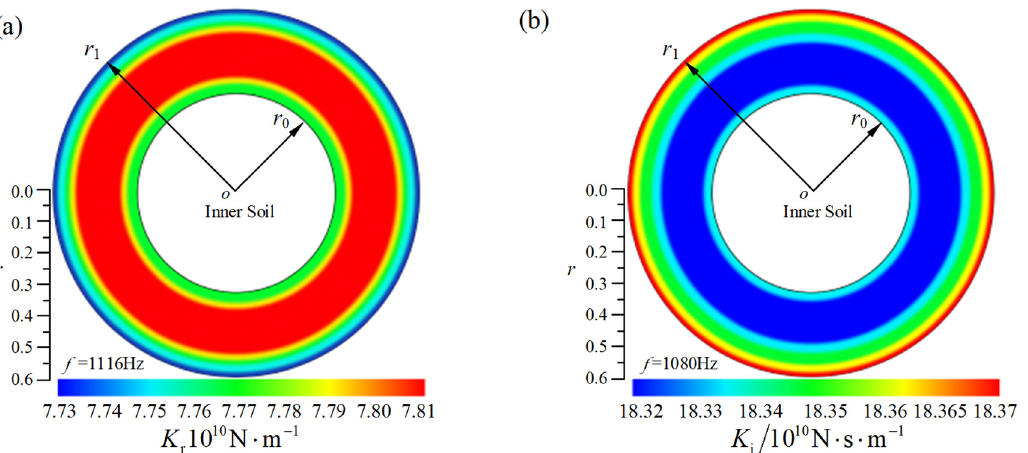
Figure 9. Variation of the pile head impedance at the cross-section of the pile (reproduced from